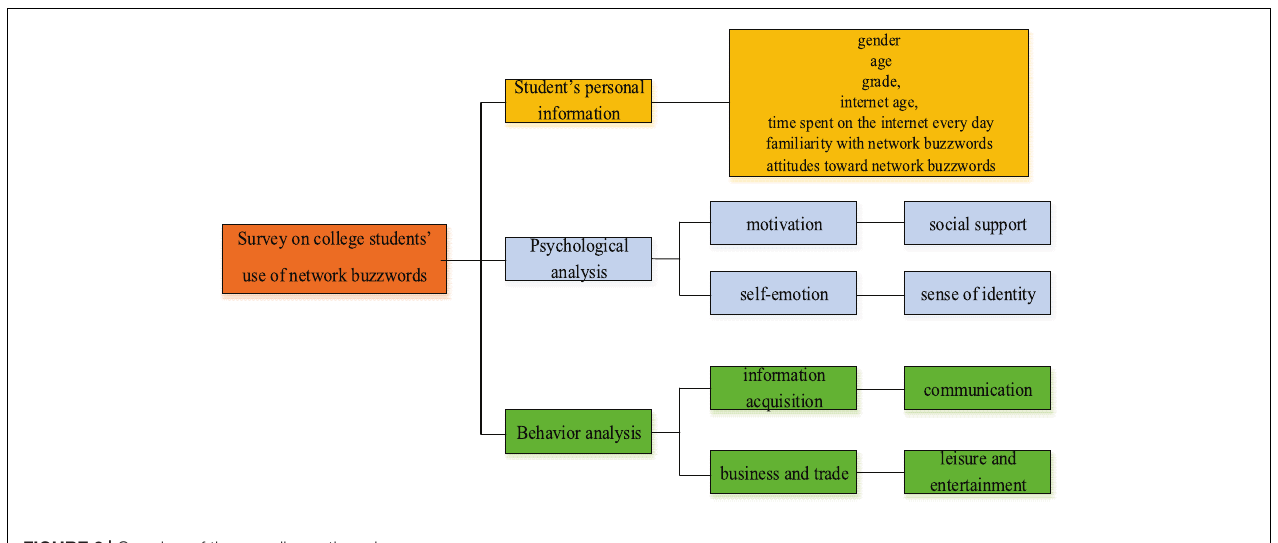
FIGURE 2 | Overview of the overall questionnaire survey.